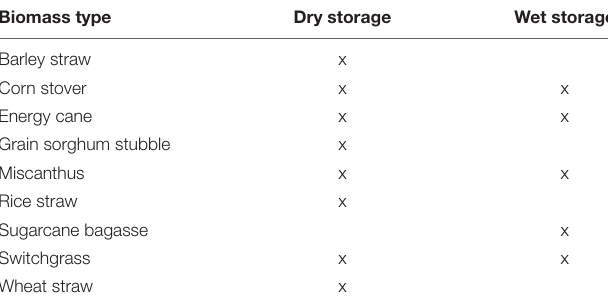
TABLE 1 | Herbaceous crop residues and energy crops identified in the Billion Ton study linked to their common storage method. Biomass type Dry